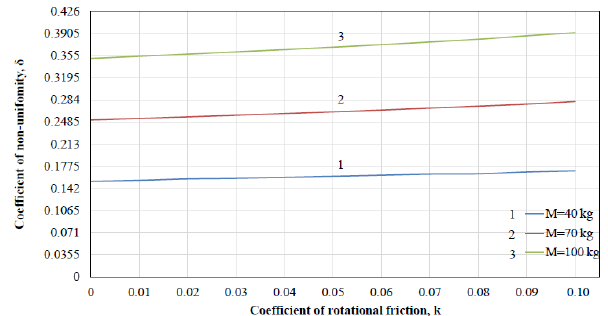
Figure 14. Dependences of coefficient of non-uniformity of rota- tion δ from coefficient of rotational friction k at coefficient of slid- ing friction f = 0 and for different values of load mass M